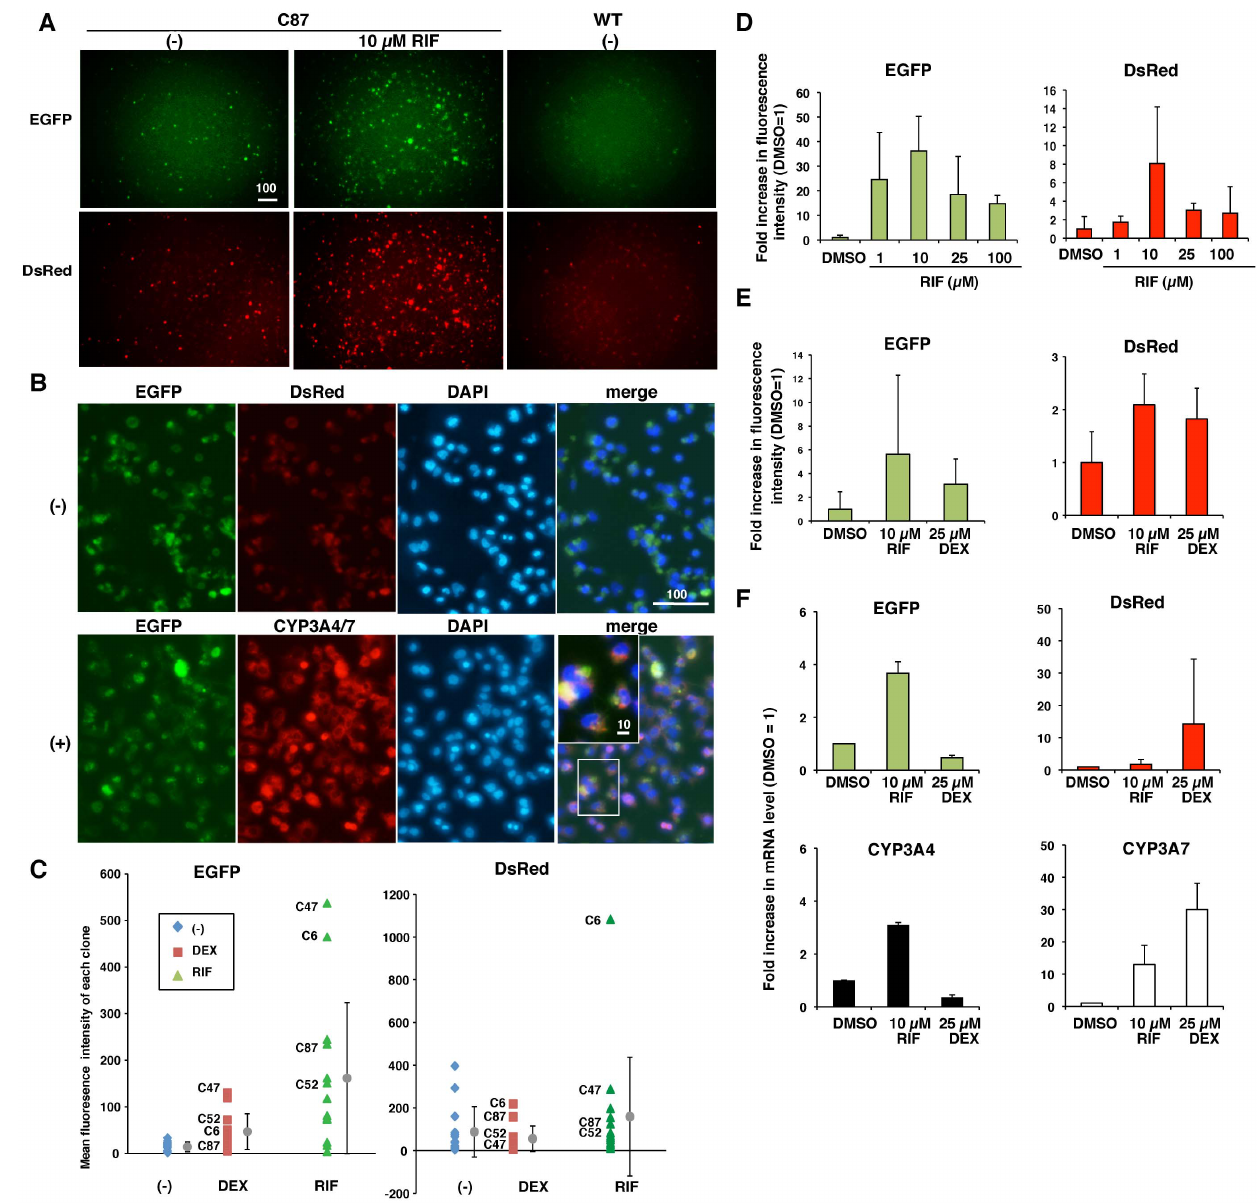
Figure 2. RIF increases the number of EGFP- and/or DsRed-positive transgenic HepG2 cells, as well as the fluorescence intensities and mRNA levels of EGFP and DsRed. (A) EGFP fluorescence and DsRed fluorescence of transgenic HepG2 clone C87 cells before ( 2 ) and after treatment with 10 m M RIF. WT: non-transgenic wild-type HepG2 cells. (B) Immunostaining of HepG2 cells for CYP3A4/7. HepG2 C87 cells exhibit EGFP and DsRed fluorescence even after paraformaldehyde fixation ( 2 ). Signals for CYP3A4/7 were much brighter when an Alexa546-conjugated secondary antibody was used ( + ). The scale bar indicates 100 m m in the image and 10 m m in the inset. (C) Representative transgenic HepG2 clones were selected in which 200 m M DEX and 100 m M RIF treatment induced high levels of fluorescence. Each point displays the mean fluorescence intensity of three independent areas in a well. The error bars show the mean 6 standard deviation (SD) of the fluorescence intensity. (D) HepG2 C87 cells at passage 7 show simultaneous induction of EGFP and DsRed fluorescence when treated with 1–100 m M RIF. For each treatment, three wells were analyzed, and the mean fluorescence intensity of three independent areas in each well was calculated, and the fold increase in fluorescence intensity in comparison to the level in 0.1% DMSO-treated cells (set at 1) is shown. (E) Fluorescence microscopic analyses showing simultaneous induction of EGFP and DsRed fluorescence following treatment with 10 m M RIF or 25 m M DEX in HepG2 C87 cells at passage 7 and passage 10. Cells were cultured in three wells for each treatment. Fluorescence intensities were measured in three areas for each well. The mean 6 SD of the fold increase in fluorescence intensity relative to the level in 0.1% DMSO-treated cells (set at 1) is shown. (F) qRT-PCR analyses showing that the fold increases in EGFP and DsRed mRNA levels matched well with those in endogenous CYP3A4 (left graphs) and CYP3A7 (right graphs) mRNA, respectively. The analyses were performed using the same HepG2 C87 cell samples as in the microscopic analyses (Fig. 2E). The mean 6 SD of the fold increase in the mRNA level relative to the level in 0.1% DMSO-treated cells (set at 1) is shown.